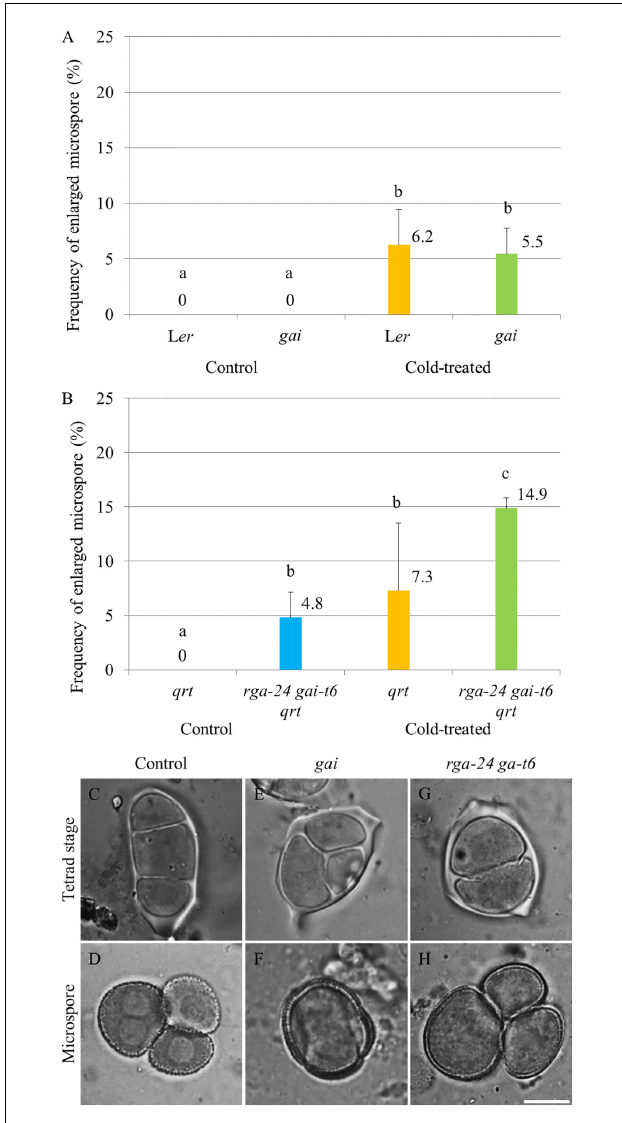
FIGURE 2 | Cold sensitivity of male sporogenesis in Arabidopsis gai and rga-24 gai-t6 mutant plants. (A,B) Histograms showing frequencies of cold-induced enlarged unicellular microspores in gai (A) and rga-24 gai-t6 (B) plants. The numbers indicate mean values of the frequency of the enlarged microspores. For each group, more than five biological replicates were performed and more than 500 microspores have been counted. Student’s t -test was used for significance. The rga-24 gai-t6 mutant plants were in qrt1-2 − / − mutant background. (C–H) Cold-induced male meiotic restitution and enlarged unicellular microspores in wild type L er (C,D) , the gai (E,F) and rga-24 gai-t6 qrt1-2 − / − (G,H) plants. Scale bar = 10 µ